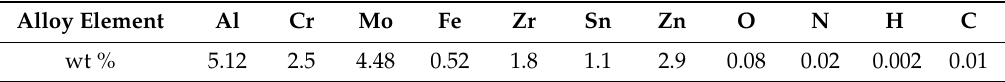
Table 1. Chemical composition (wt %) of the β 20C